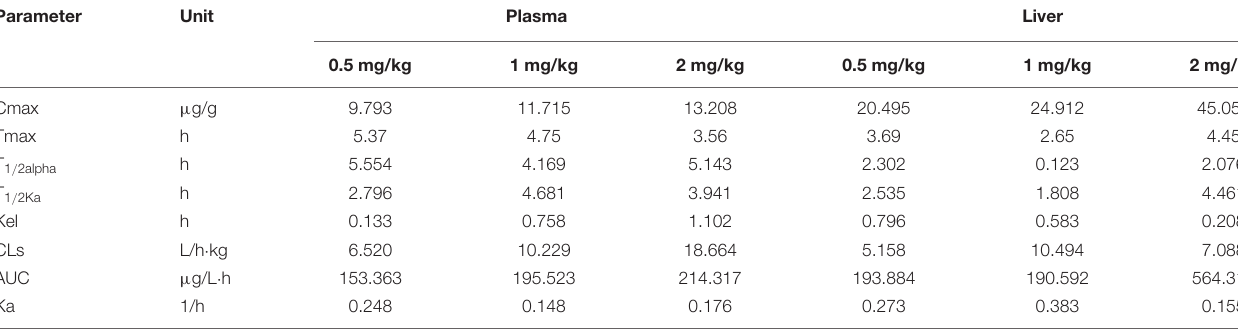
TABLE 1 | Pharmacokinetic parameters of TCF in Carassius auratus gibelio ( n = 3). Parameter Unit